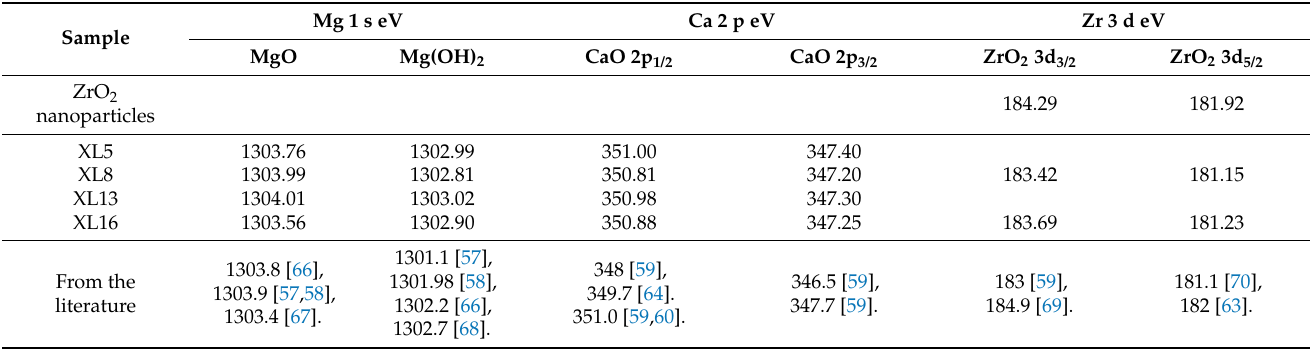
Table 3. Binding energy corresponds to Mg 1 s, Ca 2 p, and Zr 3 d of MgO, Mg(OH) 2 , CaO, CaZrO 3 , and ZrO 2 phases, corresponding to samples of 100 wt.% MgO sintered a 1550 ◦ C (XL5) and 1650 ◦ C (XL13), MgO containing 5 wt.% of ZrO 2 nanoparticles sintered at 1550 ◦ C (XL8) and 1650 ◦ C